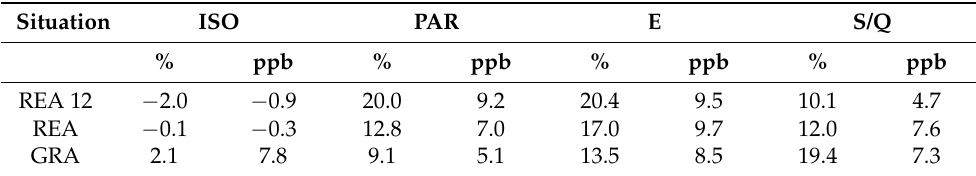
Table 3. O 3 changing rates for REA12, REA and GRA (in % and ppb) caused by the changes of one factor at 20%, while other factors kept at their originally simulated levels under realistic atmospheric conditions.